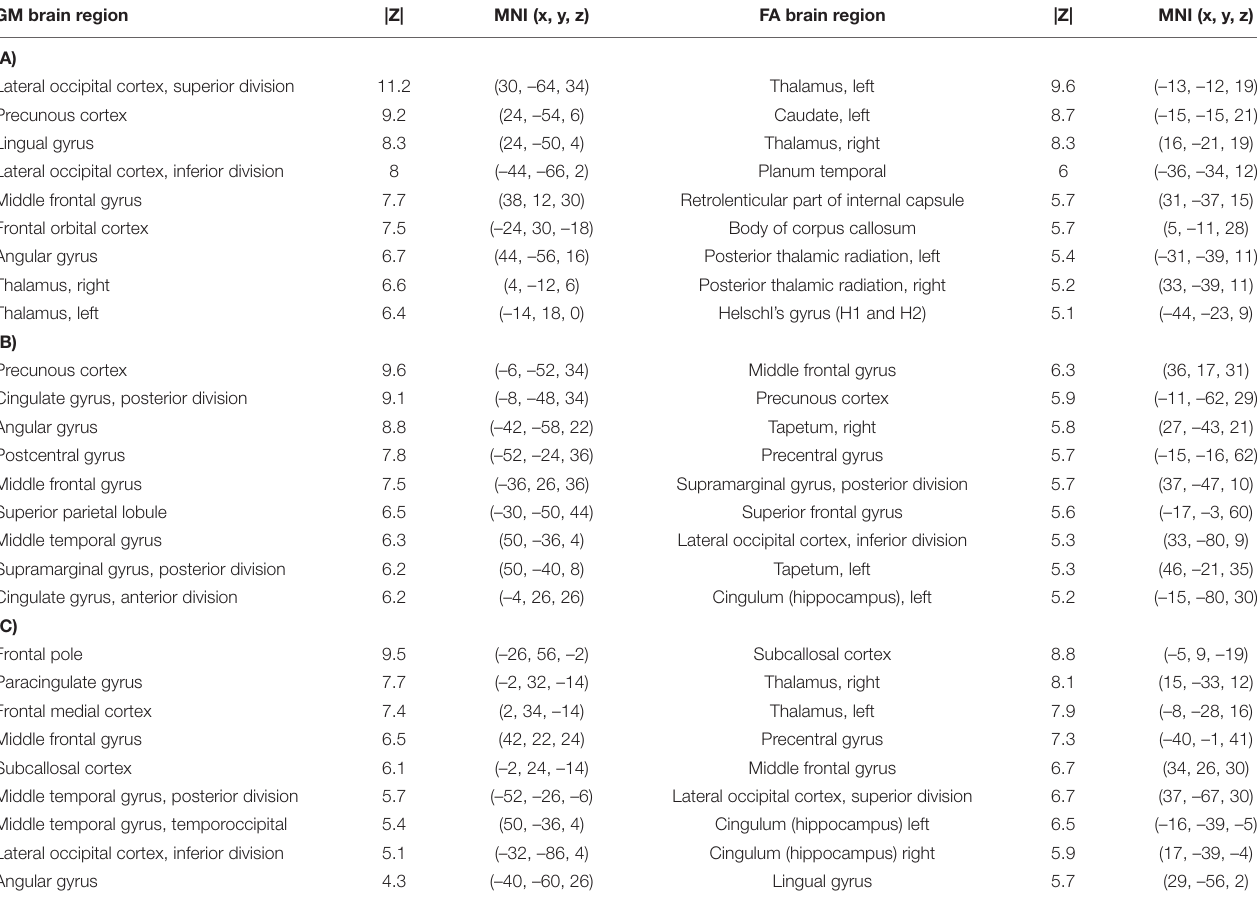
TABLE 2 | Abridged List of Brain Regions— (A) Component Pair 1, (B) Component Pair 2, (C) Component Pair